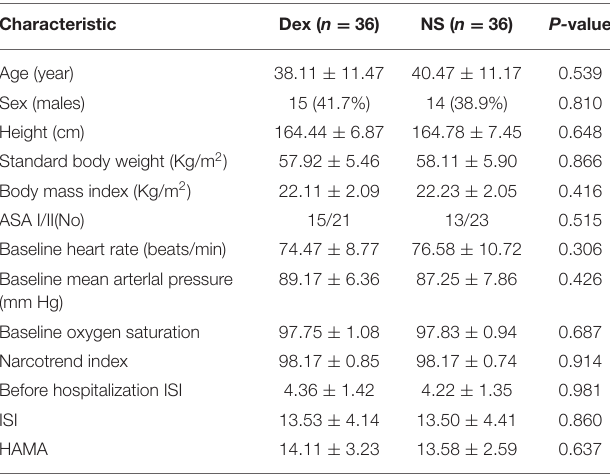
TABLE 1 | Characteristics of study